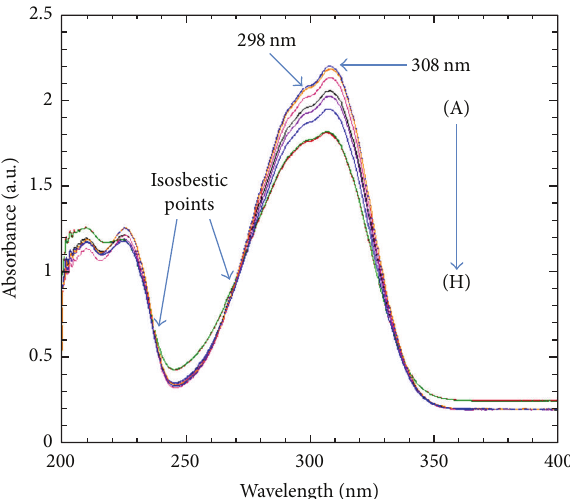
Figure 1: Absorption spectra of Cin (3.70 mM) in methanol/water mixture (85 :15, v/v) as a function of 𝛽 -CD’s concentration at 25 ∘ C. [ 𝛽 -CD] (M): (A) 0; (B) 1.50; (C) 3.01; (D) 4.56; (E) 6.21; (F) 7.98; (G) 9.45; (H) 11.00. Stirring time: 6 hours.